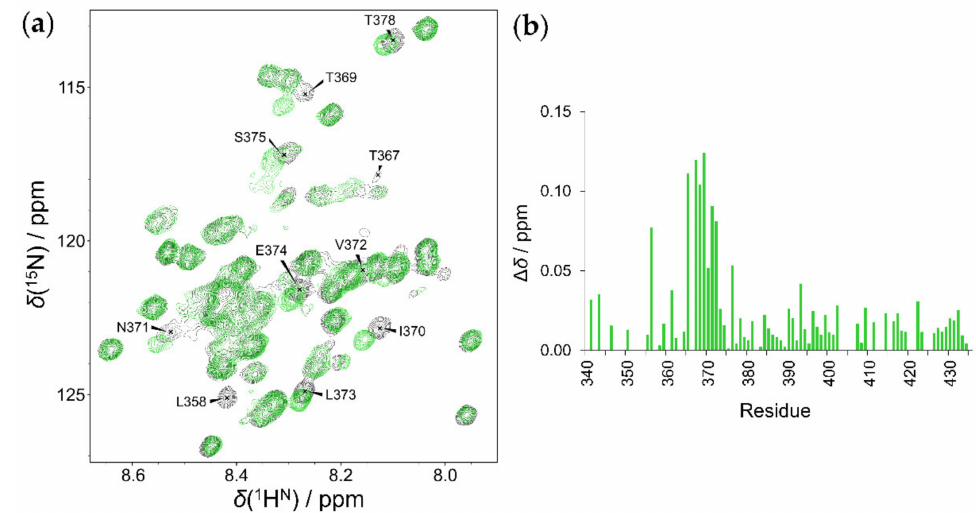
Figure 5. Interaction of HOTAIR 140 with the EZH2 loop: ( a ) 1 H- 15 N HSQC of 50 µ M wild-type EZH2 in assay buffer (black), and the same protein next to 50 µ M HOTAIR 140 (green). ( b ) Chemical shift perturbation of HOTAIR 140 on the EZH2